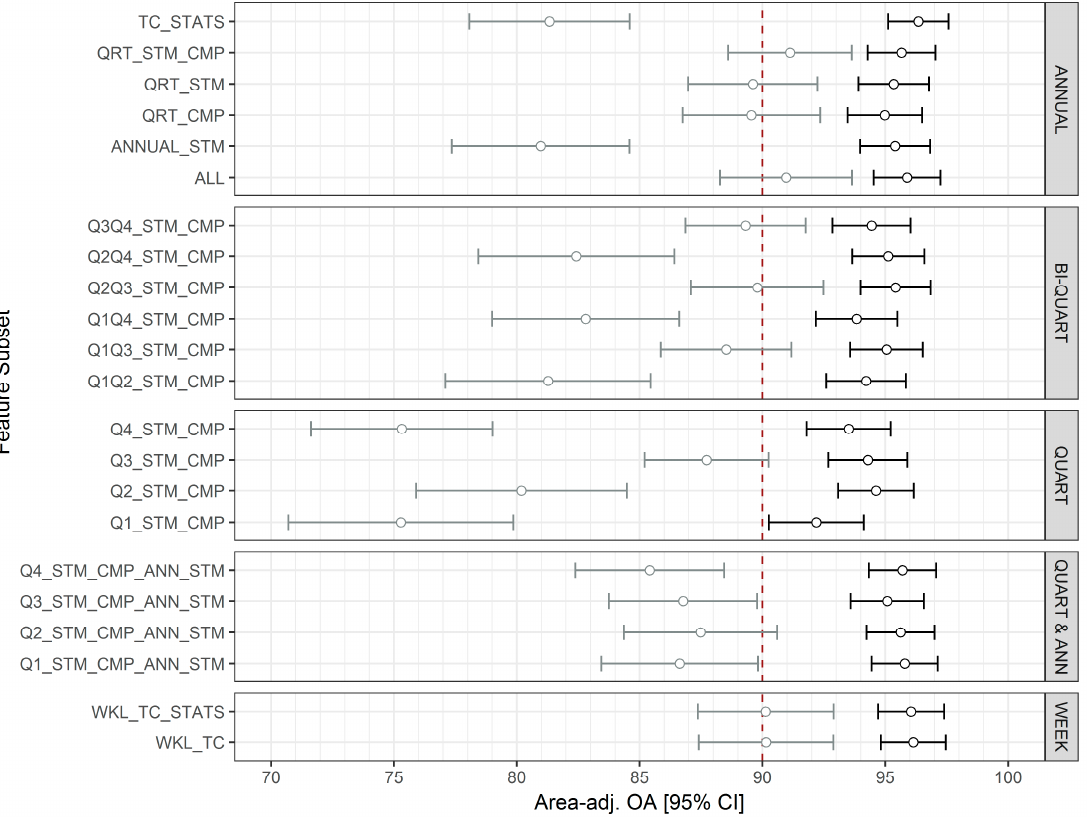
Figure 2. Area adjusted overall accuracies for binary annual cropland classification (black) and cropping practice classification (grey), for 22 feature subsets. Error bars indicate 95% confidence intervals, vertical dashed line marks 90% accuracy.